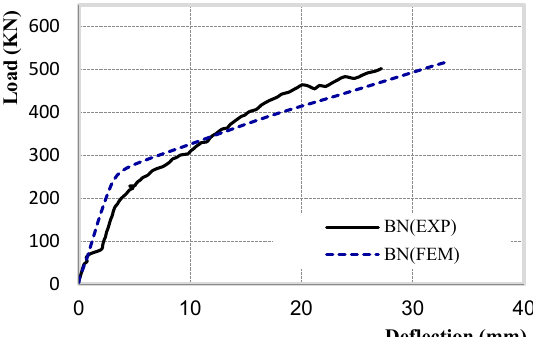
Figure 19. Load-deflection curve of BN slab.